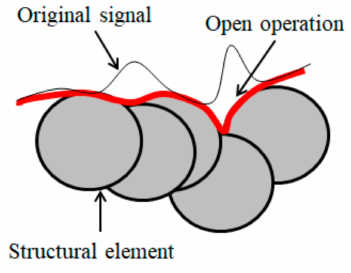
Figure 5. Opening a signal by a circular structuring